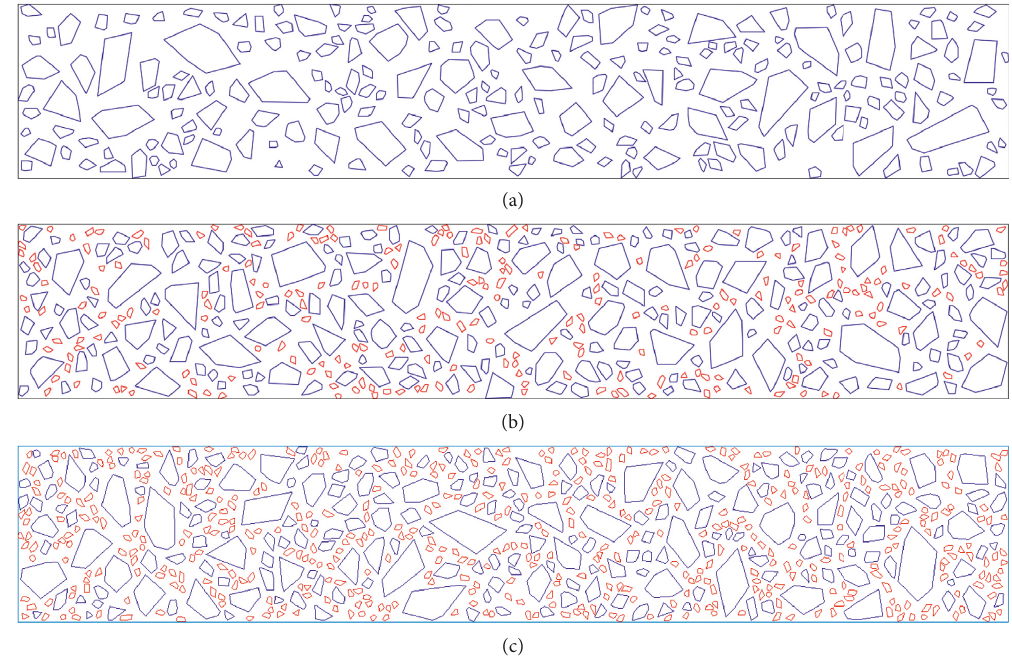
Figure 5: Irregular shape modelling for mixtures: (a) VCA � 32.3%, VV � 0%; (b) VCA � 32.1%, VV � 4%; (c) VCA � 30.7%, VV � 8%.